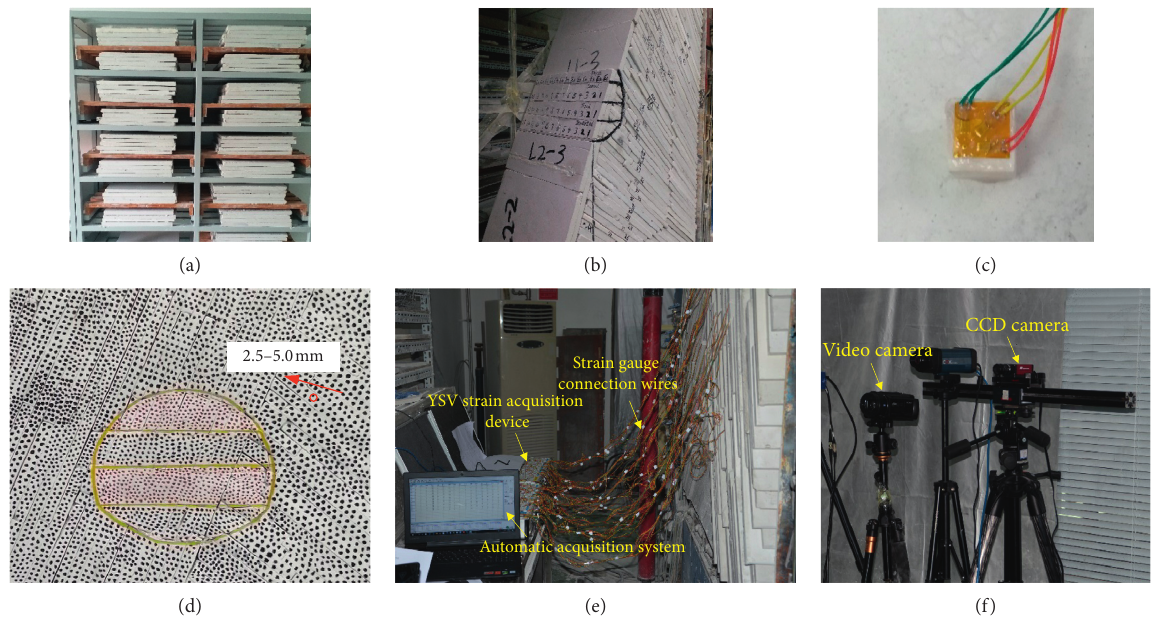
Figure 7: Testingprocess:(a) preparationof finiteelementary slabs, (b)construction of themodel, (c) embedment ofstrain gauges,(d) preparation of speckles field, (e) debugging of strain acquisition system, and (f) debugging of noncontact monitoring